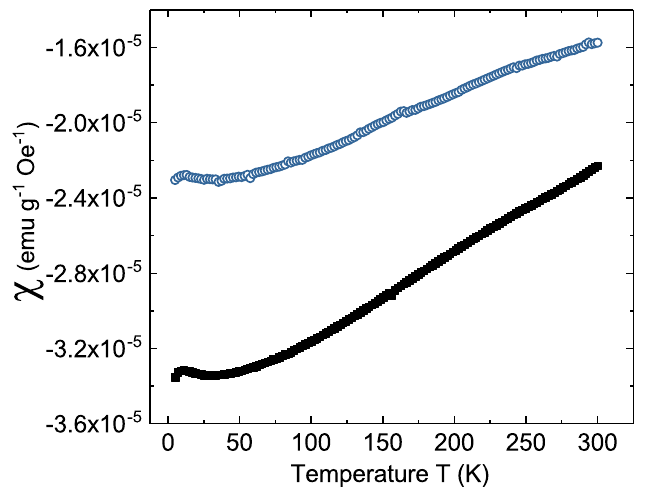
Figure 2. Temperature dependence of the mass susceptibility of two HOPG samples from the same source with thicknesses of 201 µ m (bottom curve) and 27 µ m (upper curve) measured with an SQUID